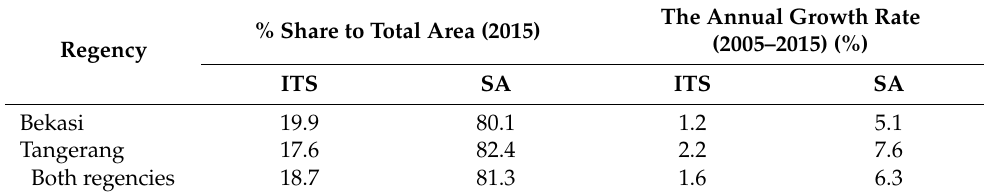
The Annual Growth